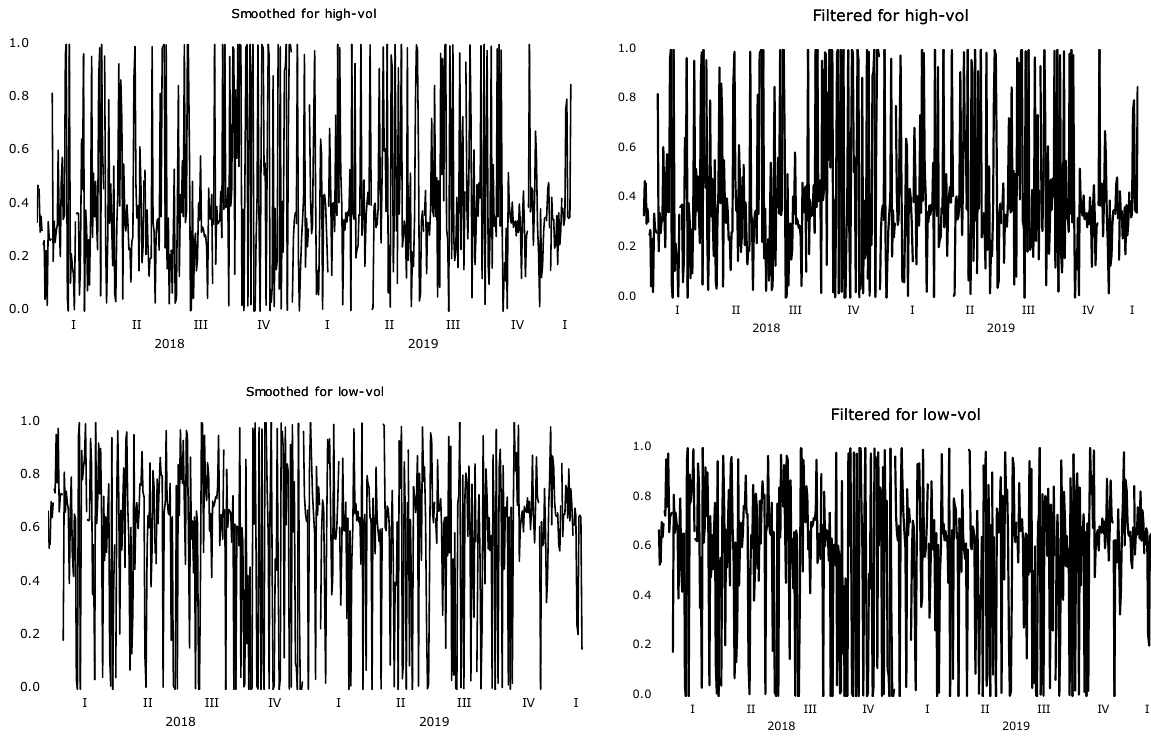
Figure 11. Computed smoothed probabilities and filtered conditional volatilities for XSW.